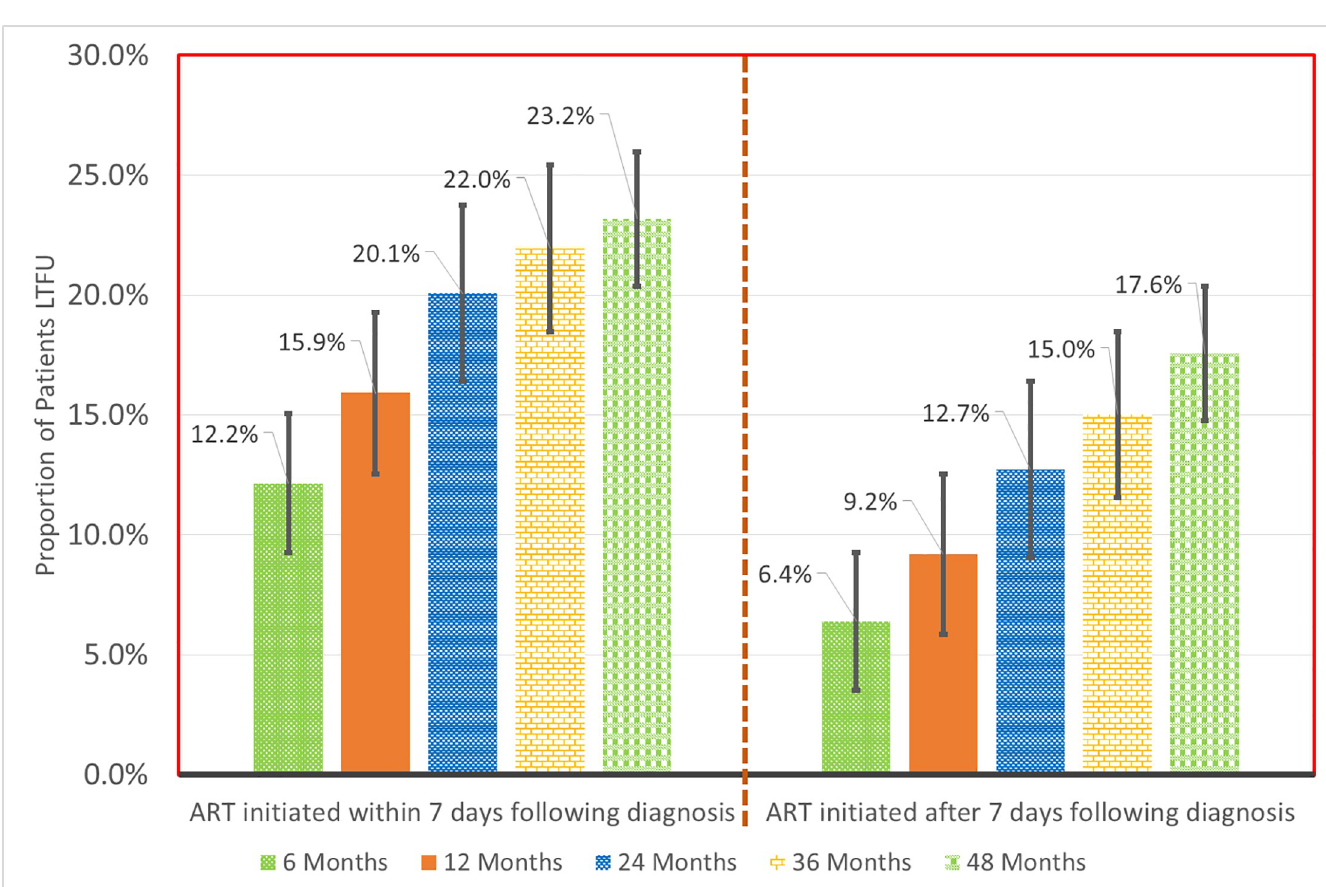
Fig 3. Cumulative incidence of loss to follow up by study group at different time